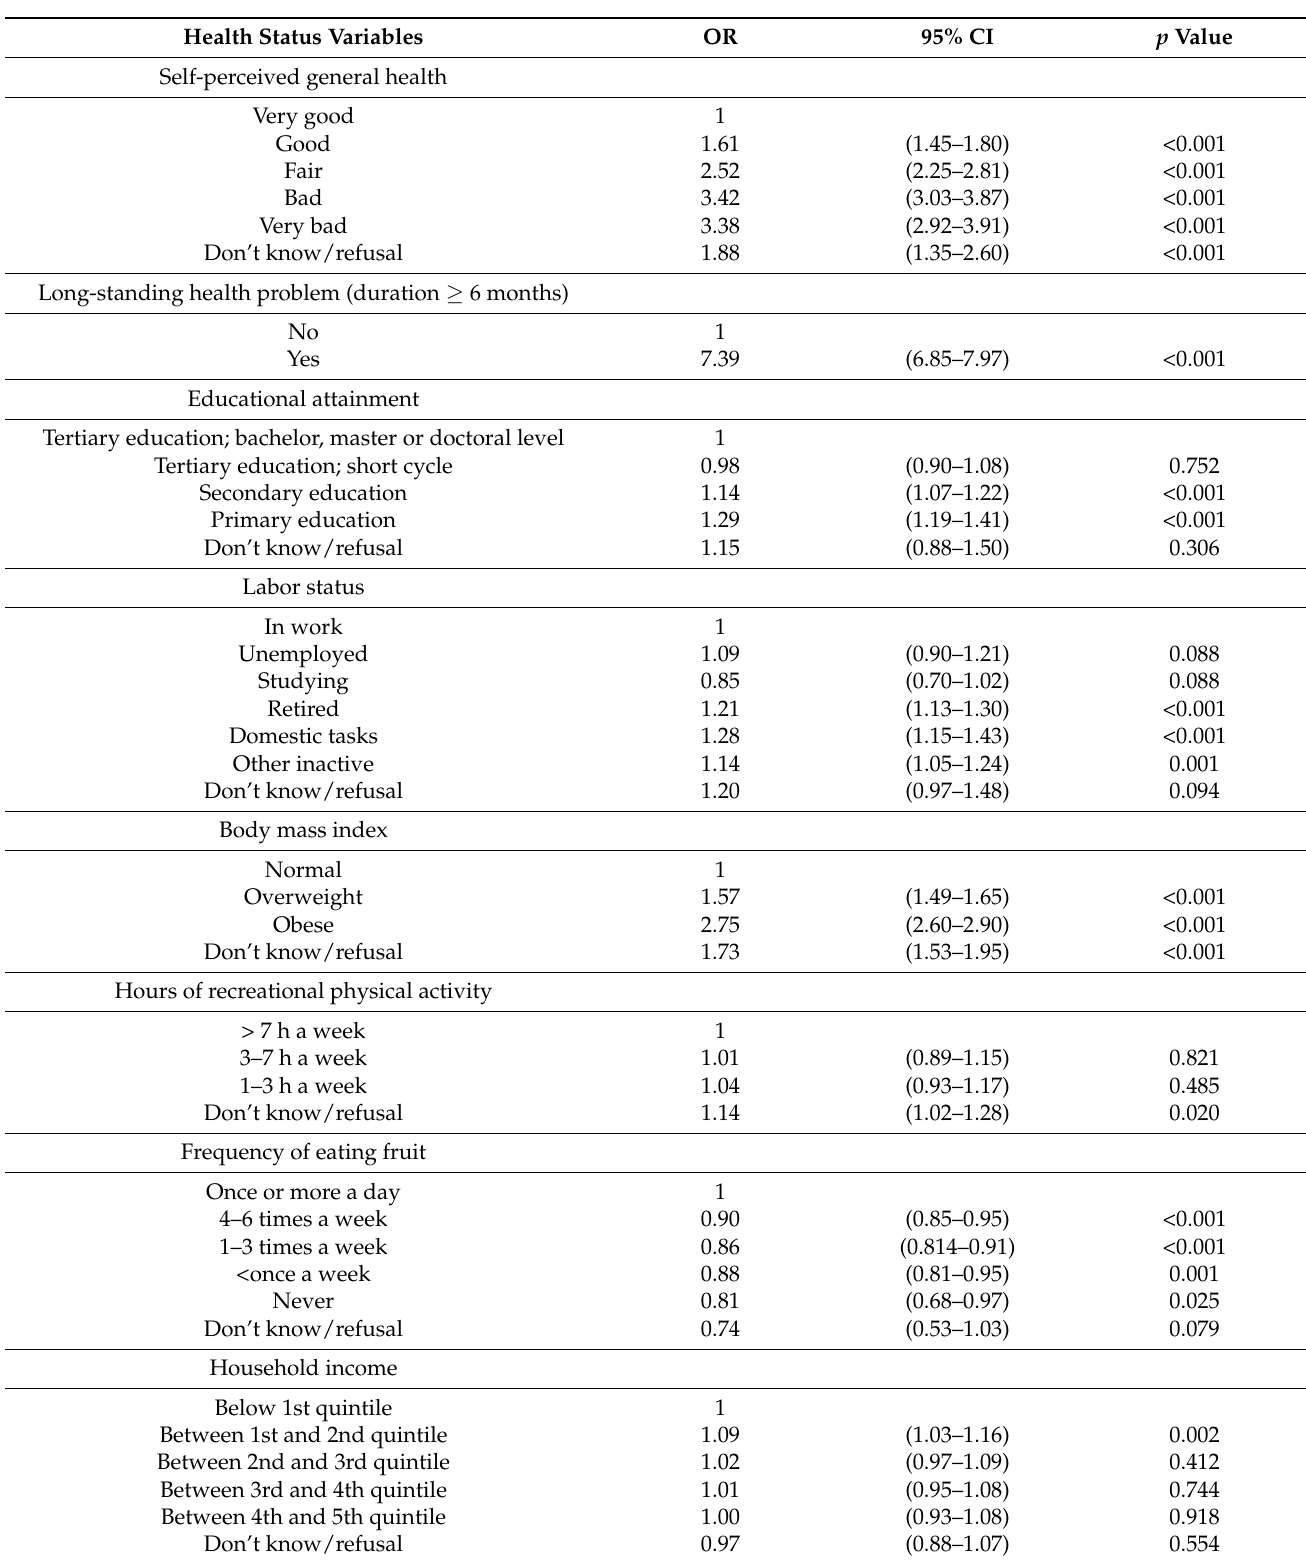
Table 2. Multiple logistic regression model for presence of